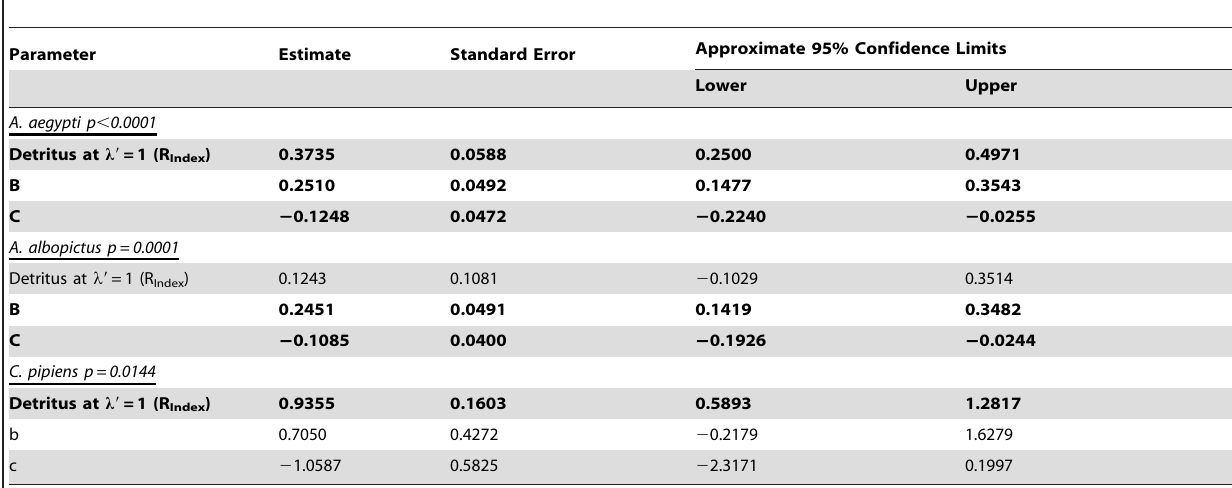
Table 2. Parameter estimates of Detritus at l 9 =1 (R Index , in dry g litter) for the three mosquito species, as well as estimates of the linear component ( b ) and the quadratic component ( c ) of each equation.